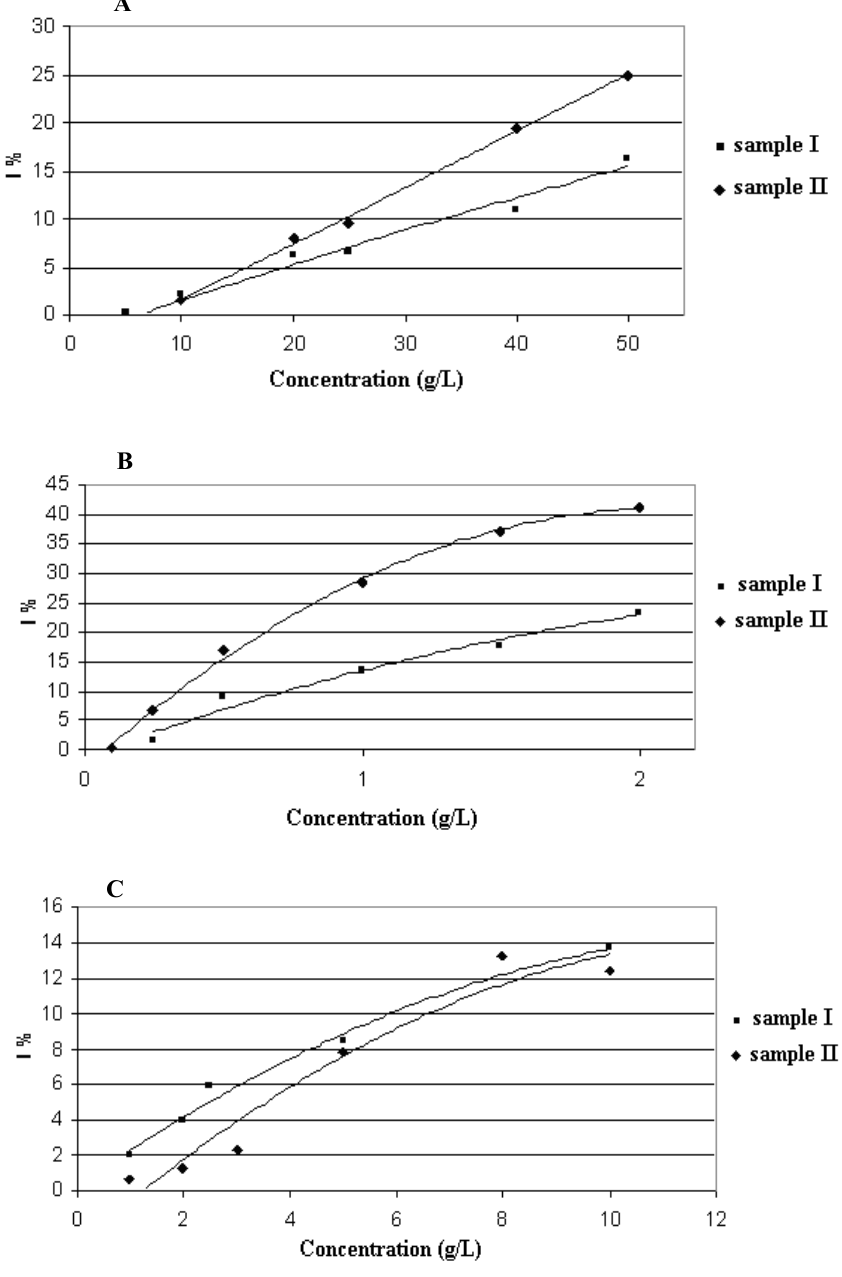
Figure 2. DPPH reduction percentage against increasing concentration of oak